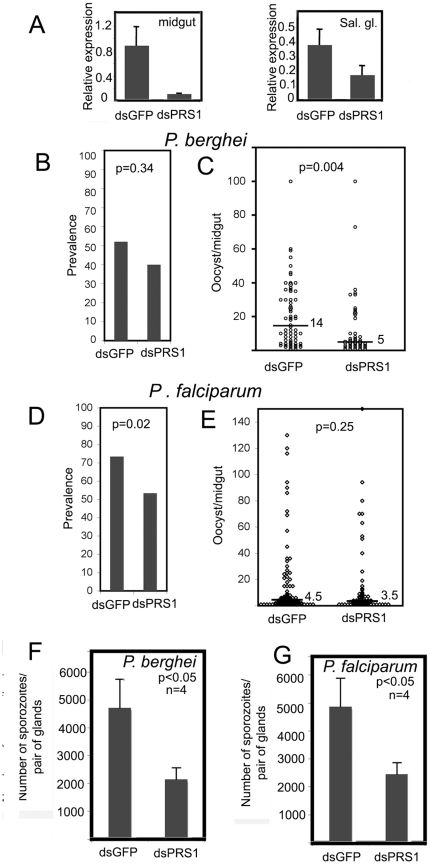

PRS1 affects An. gambiae infection with Plasmodium.A. Effects of dsRNA injection on PRS1 expression in the midgut and the salivary glands. Expression of PRS1 was analyzed by qRT-PCR in the midgut and the salivary glands three days after injection of dsPRS1 or control dsGFP. For PRS1 silencing in salivary glands, three fold higher amounts of control or specific dsRNA were injected. B–E. Oocyst prevalences and oocyst intensities in P. berghei (B, C) or P. falciparum (D, E) infected mosquitoes after injection of GFP dsRNAs (controls) or PRS1 dsRNAs. For each infecting parasite, data from four independent experiments were pooled and analyzed for prevalence values (B, D) or distribution of oocyst intensities in positive midguts (C, E). In C and E, the black bar represents the cumulated median intensity value. Statistics were computed on each individual replicate (also see Sup. Table S3) and the p values were combined using the meta-analytical approach of Fisher as described in Experimental Procedures. Injection of PRS1 dsRNA significantly decreases prevalence in P. falciparum infections and oocyst intensities in P. berghei infections compared to injection of control dsRNA. F and G. Average parasite numbers in salivary glands after infection by P. berghei (F) or P. falciparum (G) of mosquitoes treated with PRS1 and GFP dsRNA. Data were collected from four independent experiments. The standard errors are indicated. Statistically significant differences between samples were evaluated using the Mann-Whitney and Student's tests. The p-values reveal significant differences between dsGFP controls and dsPRS1 KD.